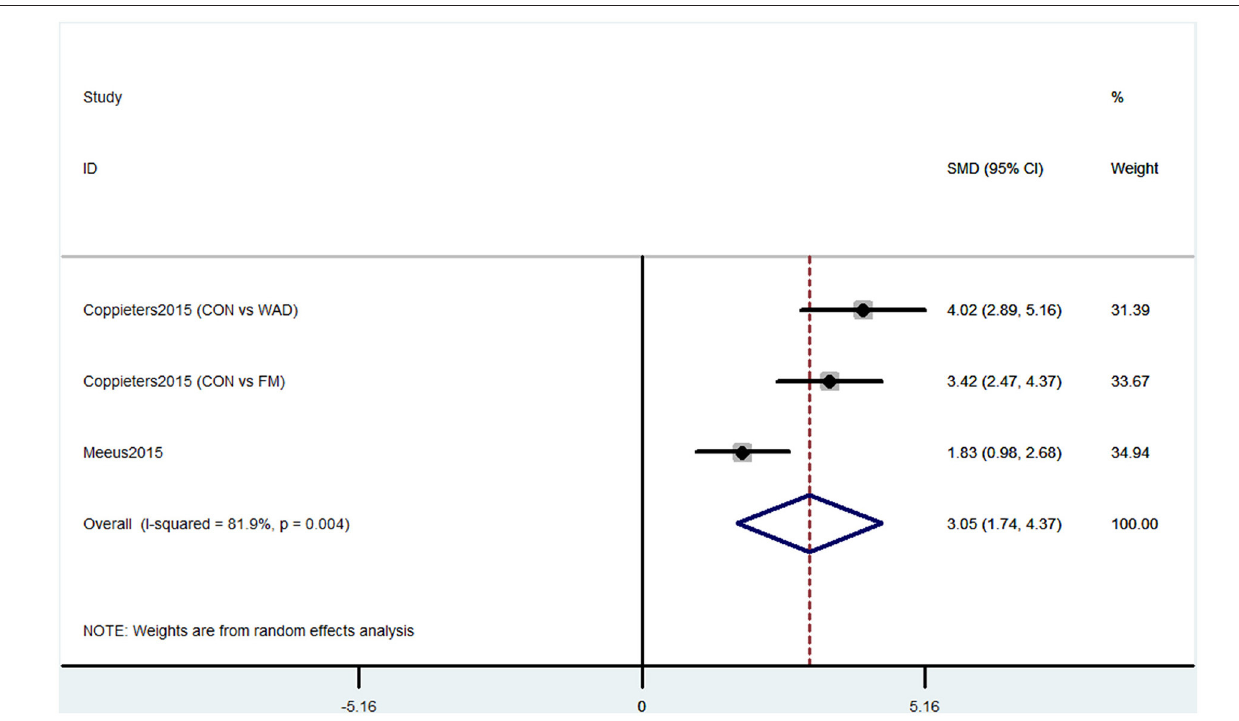
FIGURE 4 | Forest plot of the SMD and 95% CI from a random-effects meta-analysis for the association between chronic pain and incidence of cognitive decline when PVT was used. The rhombi represent the pooled SMD for this association. CON, control group; WAD, whiplash-associated disorder group; FM, fibromyalgia syndrome